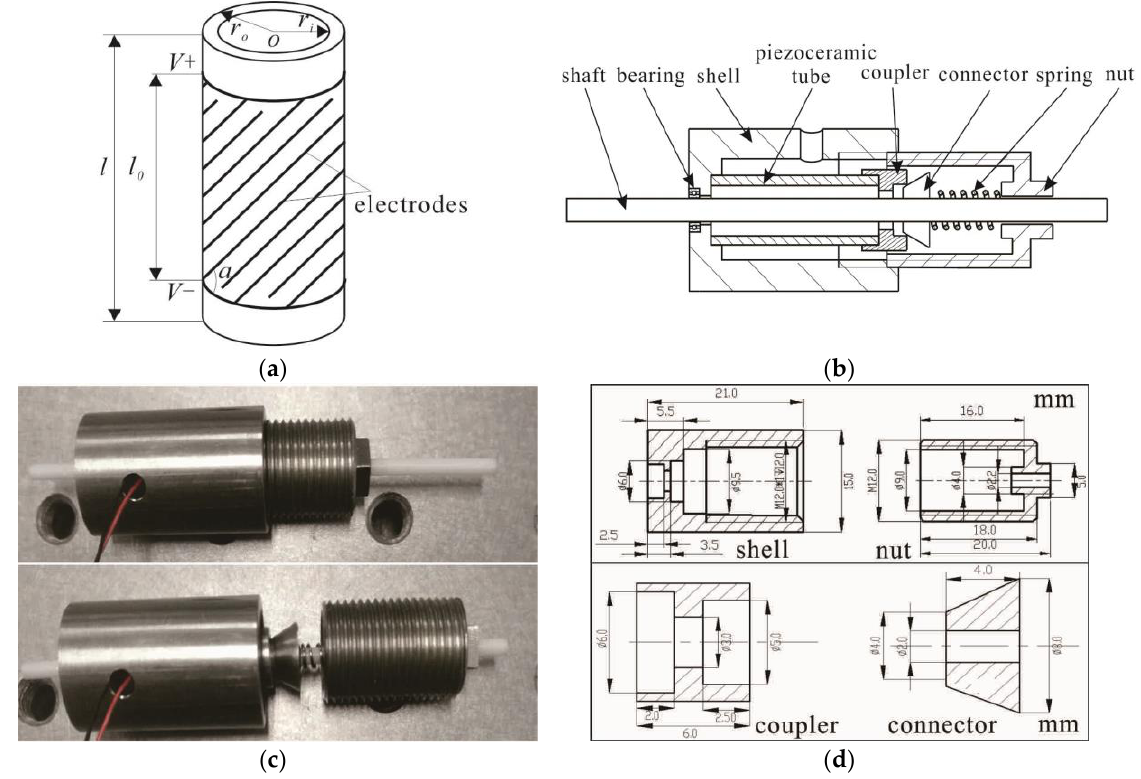
Figure 2. Structure of the rotary motor: ( a ) Schematic diagram of the piezoelectric tube; ( b ) Cross-sectional view of the motor model; ( c ) The prototype motor; ( d ) Dimensions of the shell, nut, coupler, and connector.